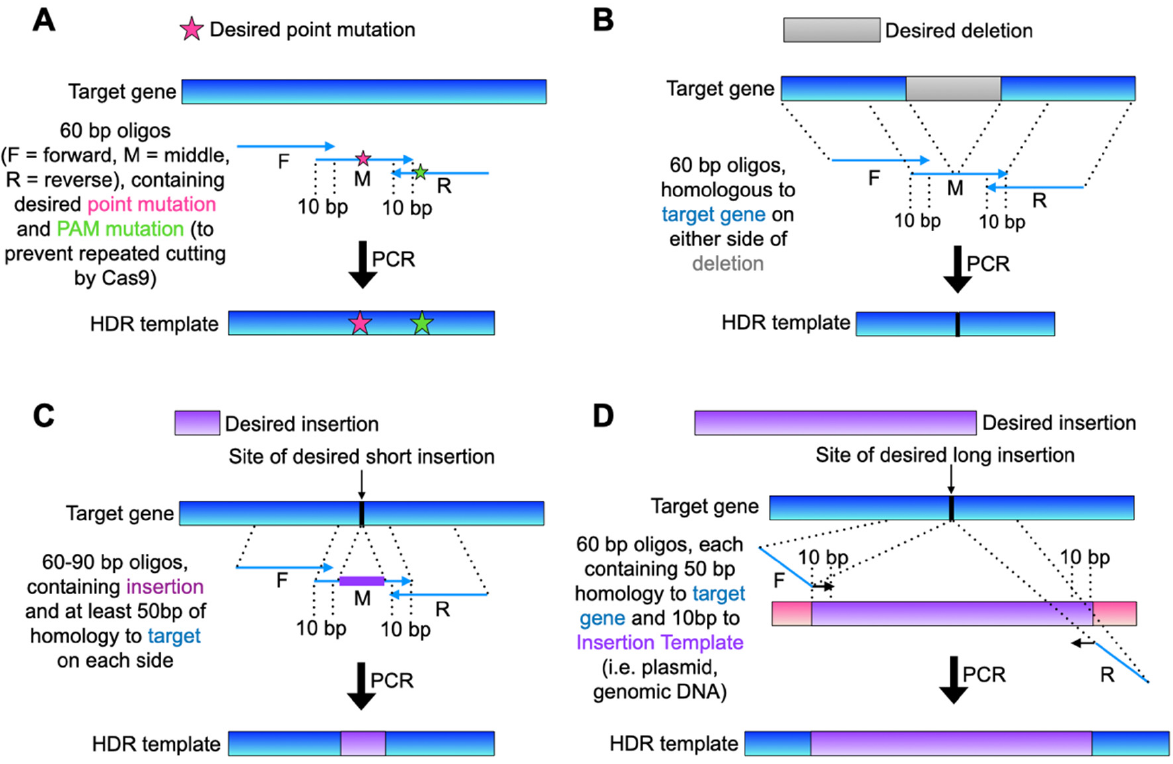
Figure 3. Representation of the HDR template design for a ( A ) few base-pair point mutations, ( B ) large deletion, ( C ) short ( ≤ 80 bp) insertion, or ( D ) long (>80 bp) insertion into the yeast genome. Note: as indicated in Section 3.1, a silent mutation of the PAM (or another other portion of the gRNA target sequence) should be always included if the mutation does not otherwise disrupt the gRNA target, to prevent repeated cutting by Cas9 after repair is